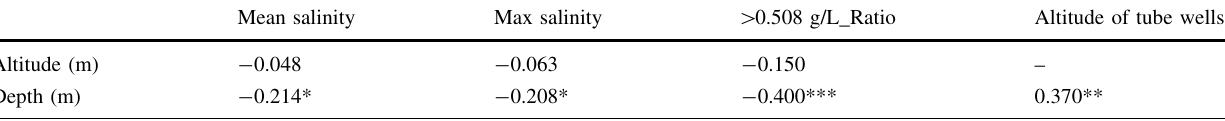
Table 2 Correlation between salinity levels, depth, and altitude of tube wells in the study area in Chakaria Upazila, Bangladesh, 12 February–13 May 2016